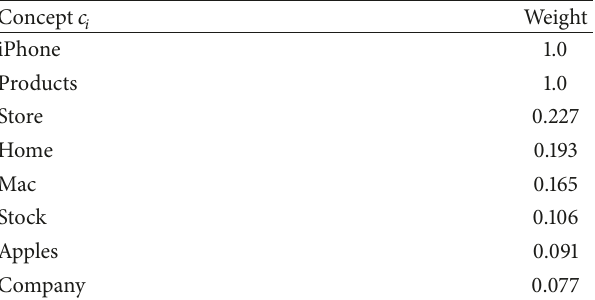
Table 2: The user context by concept relationship graph in Figure 2 and click snippet in Figure 1.